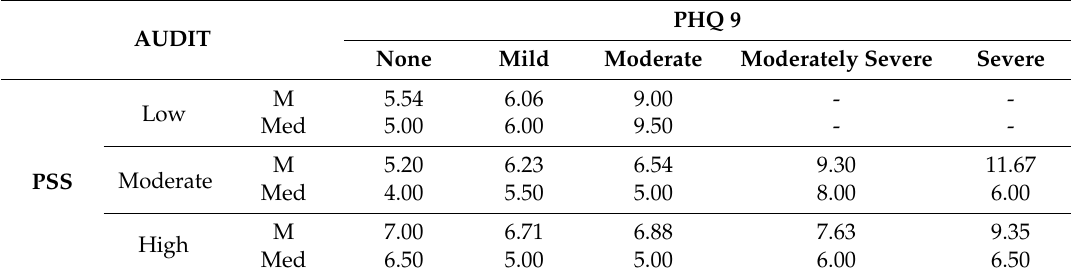
Table 3. AUDIT (Alcohol Use Disorders Identification Test) score in a combination of Perceived Stress Scale (PSS) and Patient Health Questionnaire (PHQ 9) intervals.